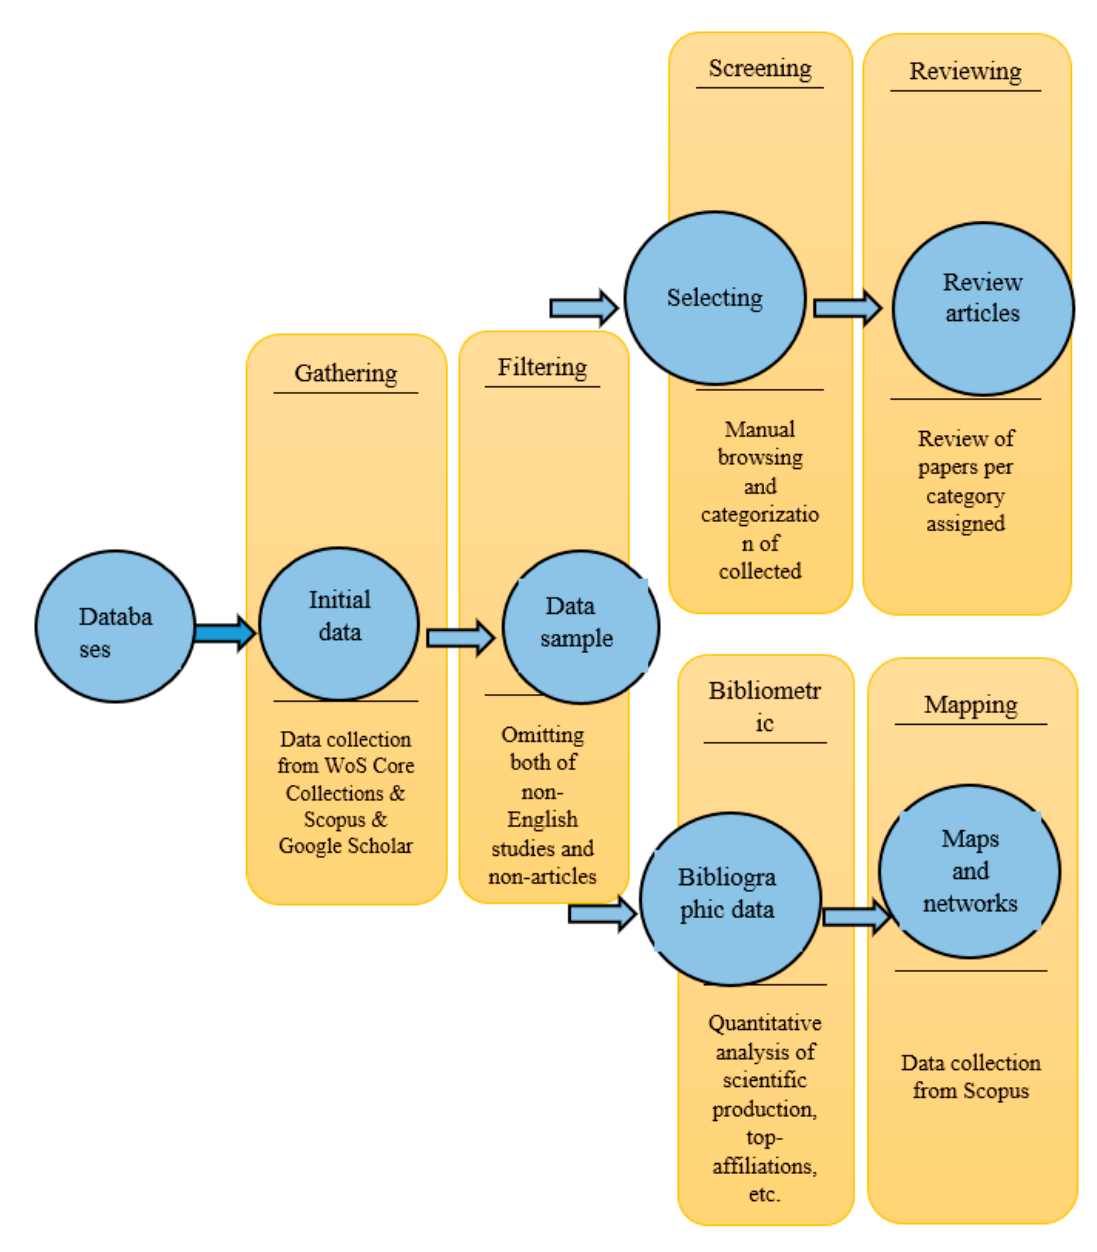
Figure 1. Paper selection process scheme.